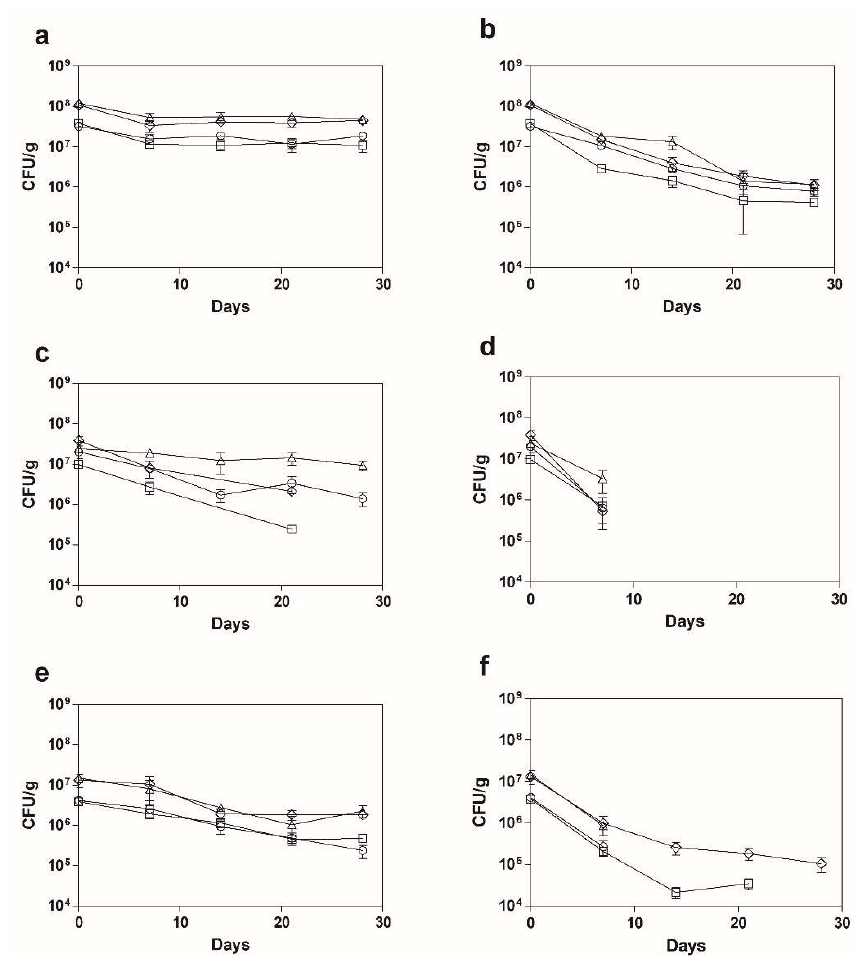
Figure 1. Viability of spray dried A. muciniphila cells throughout aerobic storage. Cells were pro- cessed in SM ( a , b ), WPC ( c , d ) and WPI ( e , f ), using the previously described four conditions: #1— circles; #2—triangles; #3—diamonds; #4—squares. Samples were stored for 28 days at 4 ( a , c , e ) or 22 °C ( b , d , f ), under aerobic atmosphere and controlled